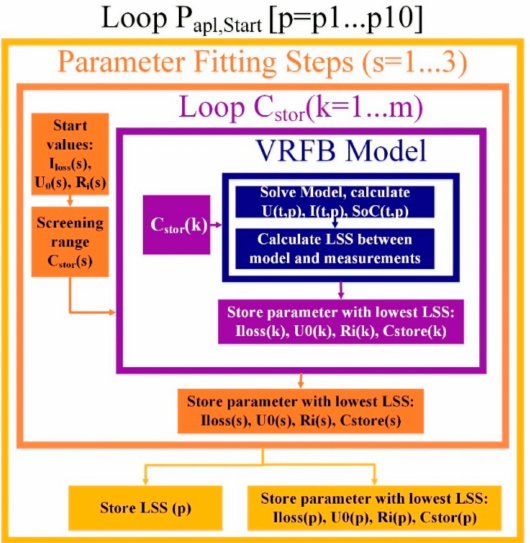
Figure 6. Schematic illustration of the steps performed during the fitting process (index p is used as an index in vector P apl = [1, 2.5, 5, 7.5, 10] in kW for varying the input data scope, index s is used for